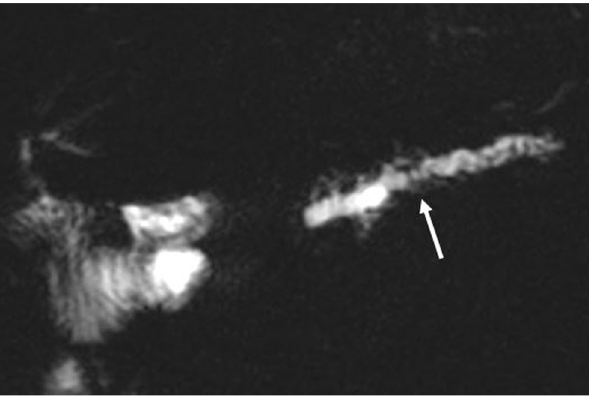
Fig. 27 MRCP reveals a marked dilation of the main pancreatic duct and of some branch ducts (white